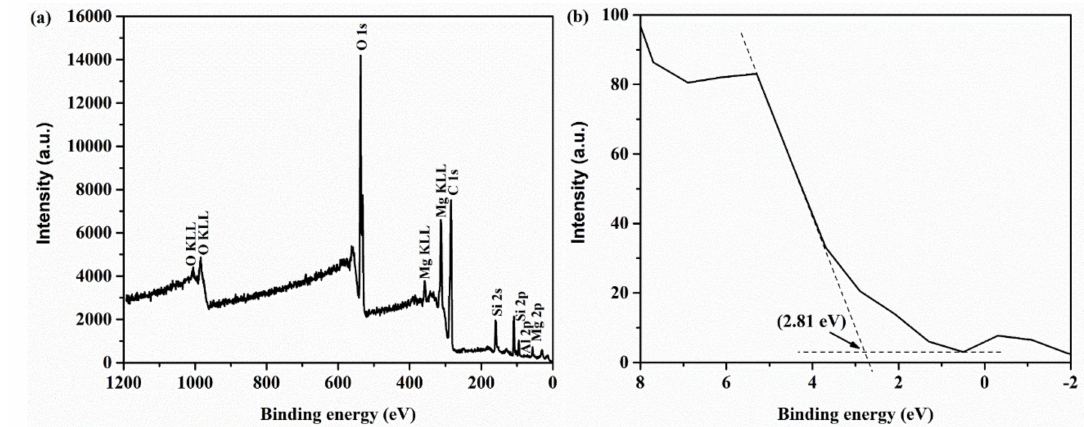
Figure 4. XPS spectrum of sepiolite. ( a ) Survey scan and ( b ) valence band (VB) energy region.